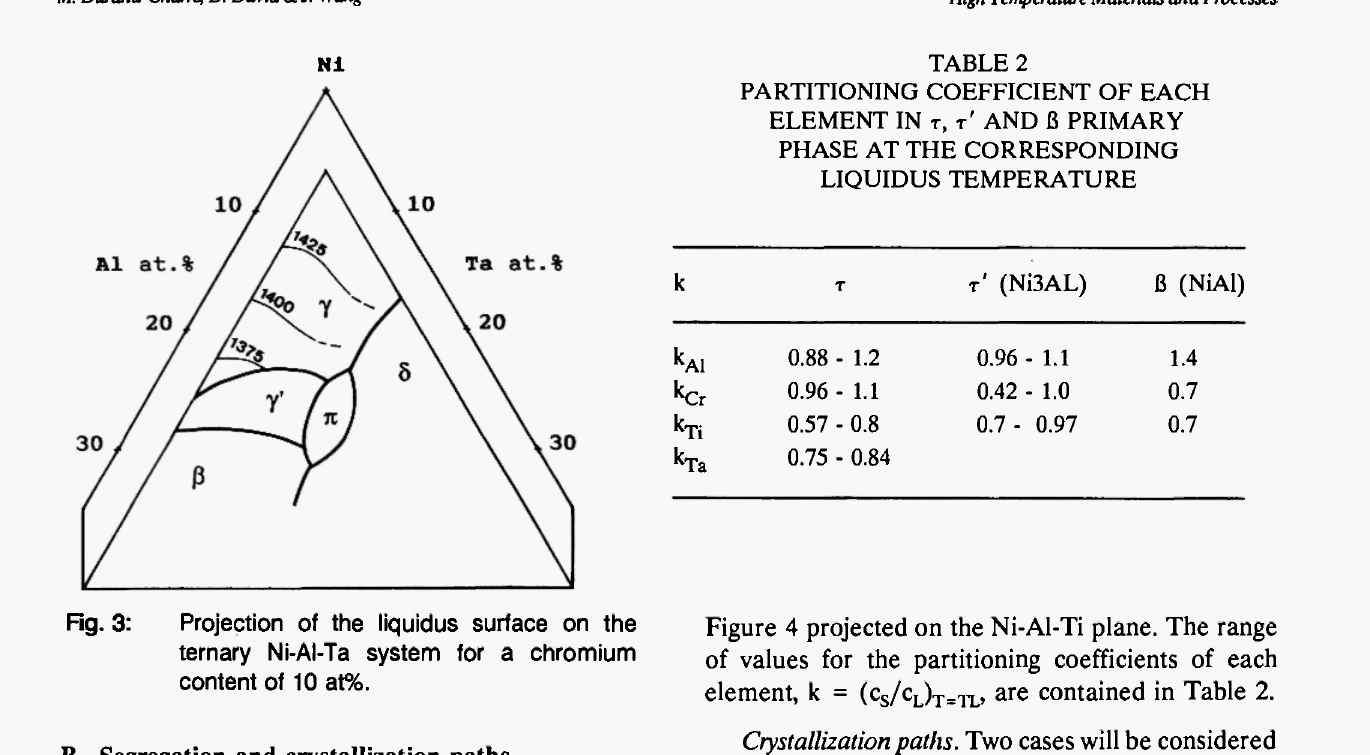
Figure 4 projected on the Ni-Al-Ti plane. The range of values for the partitioning coefficients of each element, k = (c s /c L ) T=XL , are contained in Table 2.